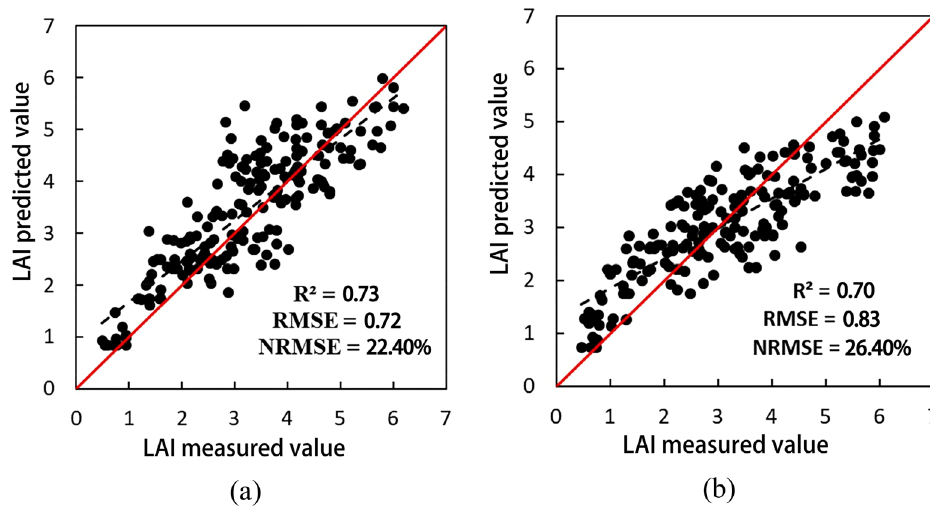
Figure 4. Scatter plots of the LAI estimated and measured values in 2014 ( a ) and 2015 ( b